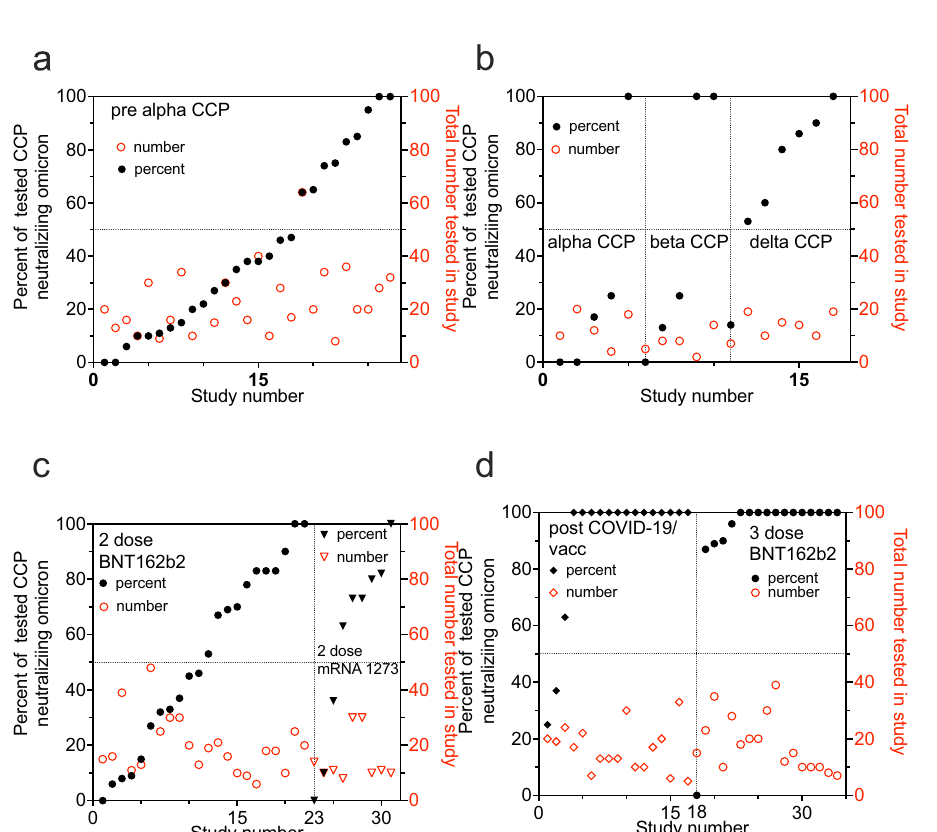
OmicronBA.1; b Alpha,BetaandDeltaCCPneutralizationofOmicronBA.1; c 2-dose mRNAvaccinesneutralizationofOmicronBA.1 d